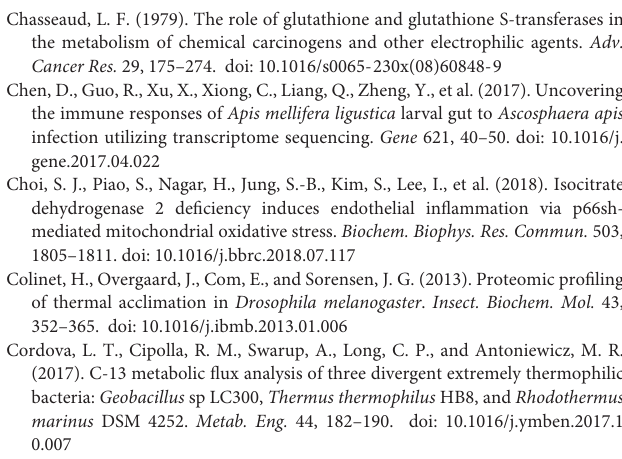
TABLE S3 | Primers used in the RT-qPCR in this study. TABLE S4 | Up-regulated genes in HTAS of Neoseiulus barkeri transcriptomes. TABLE S5 | Up-regulated proteins in HTAS of Neoseiulus barkeri proteomes. TABLE S6 | Down-regulated proteins in HTAS of Neoseiulus barkeri proteomes. TABLE S7 | Correlation between mRNAs and proteins with the same trend. TABLE S8 | Correlation between mRNAs and proteins with the opposite